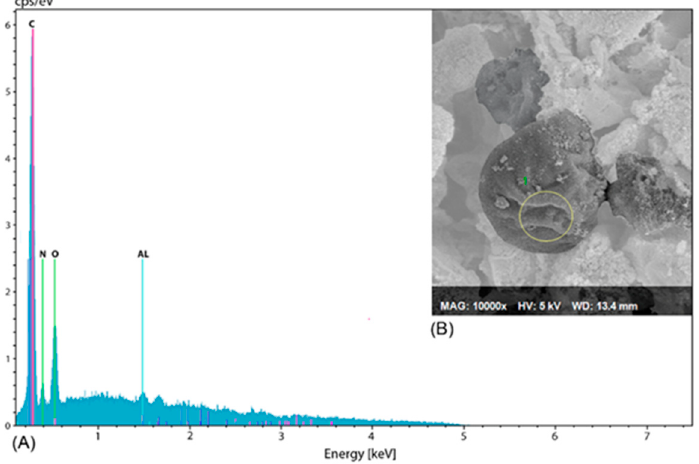
Figure 4. CPCC 90 Chlorella vulgaris cells analysis with ( A ) EDX and ( B ) SEM. Samples correspond to a 12 day cultivation time and are grown with a nominal concentration of 60 mM of NaHCO 3 .